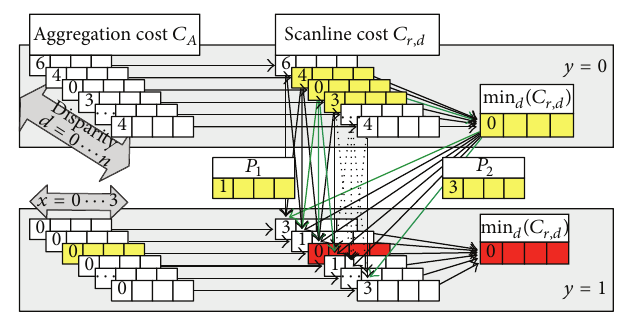
Figure 11: Illustration of downward scanline compute pattern with blocks of width 4 indicating the unrolling potential in 𝑥 -dimension. Arrows indicate dependencies; for the computation of the red boxes (scanline cost is computed; minimum is updated), data from all yellow boxes is required. Paths are chosen either as previous scanline cost at the same disparity without any penalty (red box) or as previous scanline cost at neighboring disparity plus penalty 𝑃 1 (boxes next to red box) or as global minimum of previous line plus penalty 𝑃 2 (outer